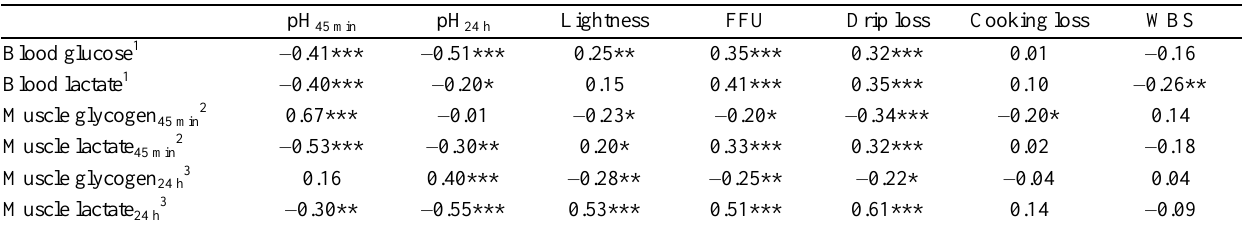
Table 2. Correlation coefficients between blood and muscle metabolites and certain pork quality